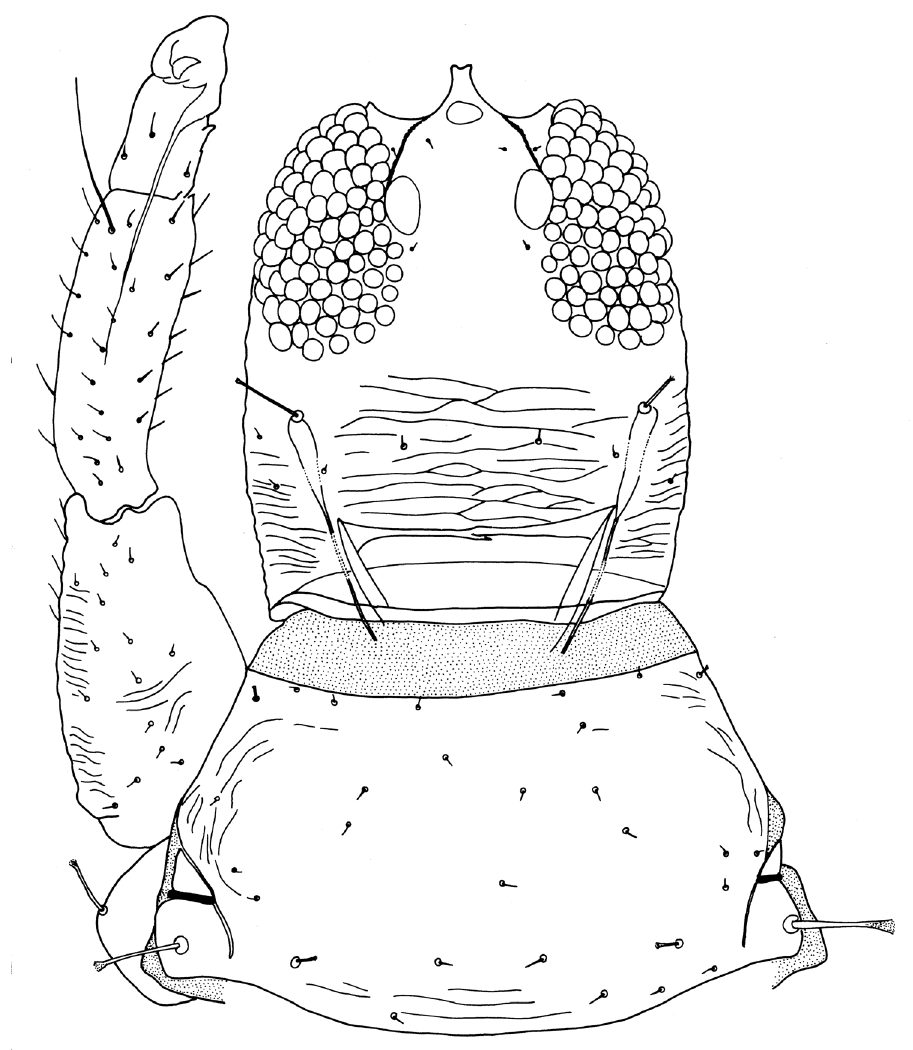
Figures 3. Haplothrips shivendraii sp. n.: Head and Prothorax with fore leg